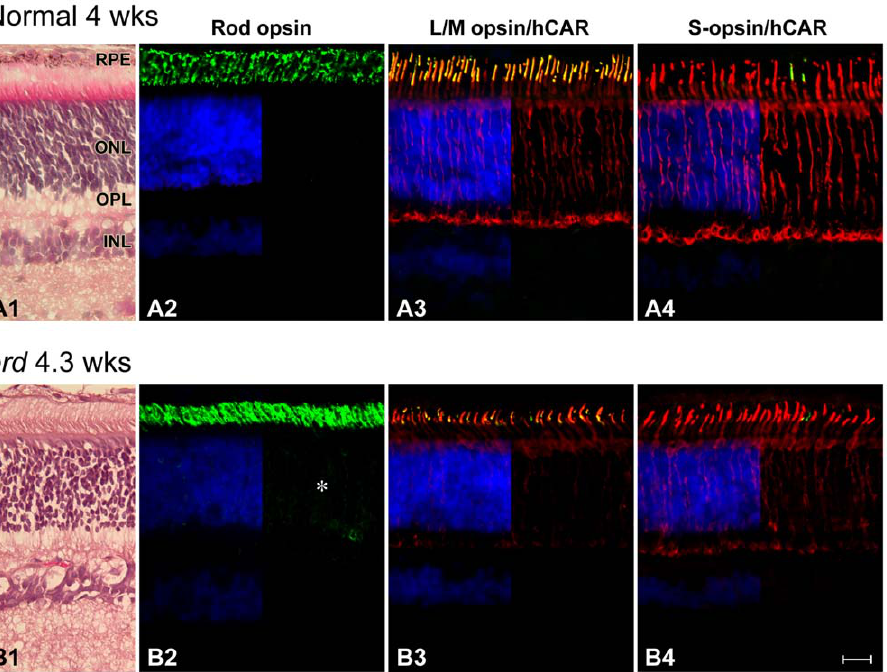
Figure 1. Normal expression of rod and cone molecular markers in early development in erd . Sections from 4 wk normal ( A ) and 4.3 wk mutant ( B ) stained with H&E (A1, B1), or labeled with antibodies against rod opsin (A2, B2; green), L/M-cone opsin (COS-1, green)/hCAR (red) (A3, B3), and S-cone opsin (OS-2, green)/hCAR (red) (A4, B4) with a DAPI (blue) nuclear stain. With the exception of rod opsin which shows slight delocalization of label into the outer nuclear (*) and plexiform layers, opsin labeling is restricted to the outer segments. hCAR labeling of cones is present throughout the cell. RPE=retinal pigment epithelium, ONL=outer nuclear layer, OPL=outer plexiform layer, INL=inner nuclear layer. Scale bar 40 m